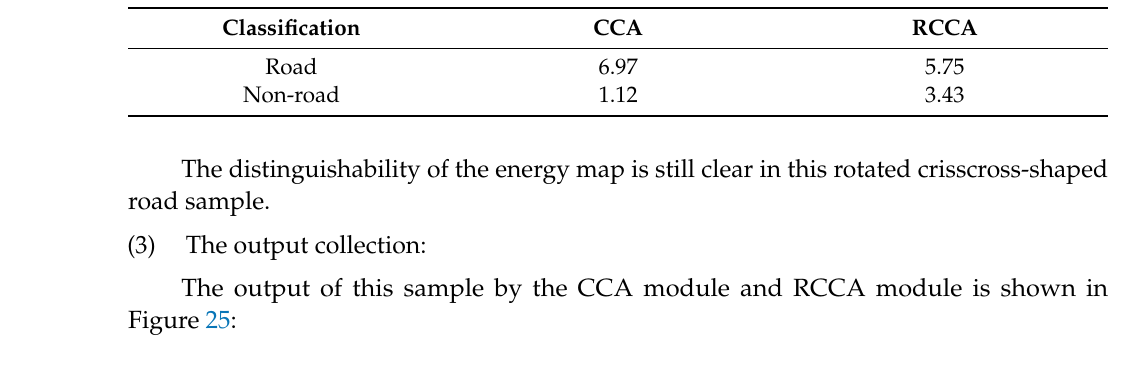
Table 7. The energy comparison of CCA and RCCA sampling.